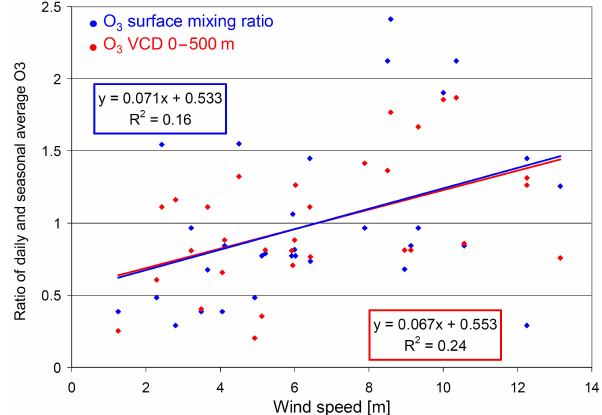
Figure A5. Dependence of the surface mixing ratios and O 3 VCDs on wind speed. To account for the seasonal differences, the daily values are divided by the respective seasonal